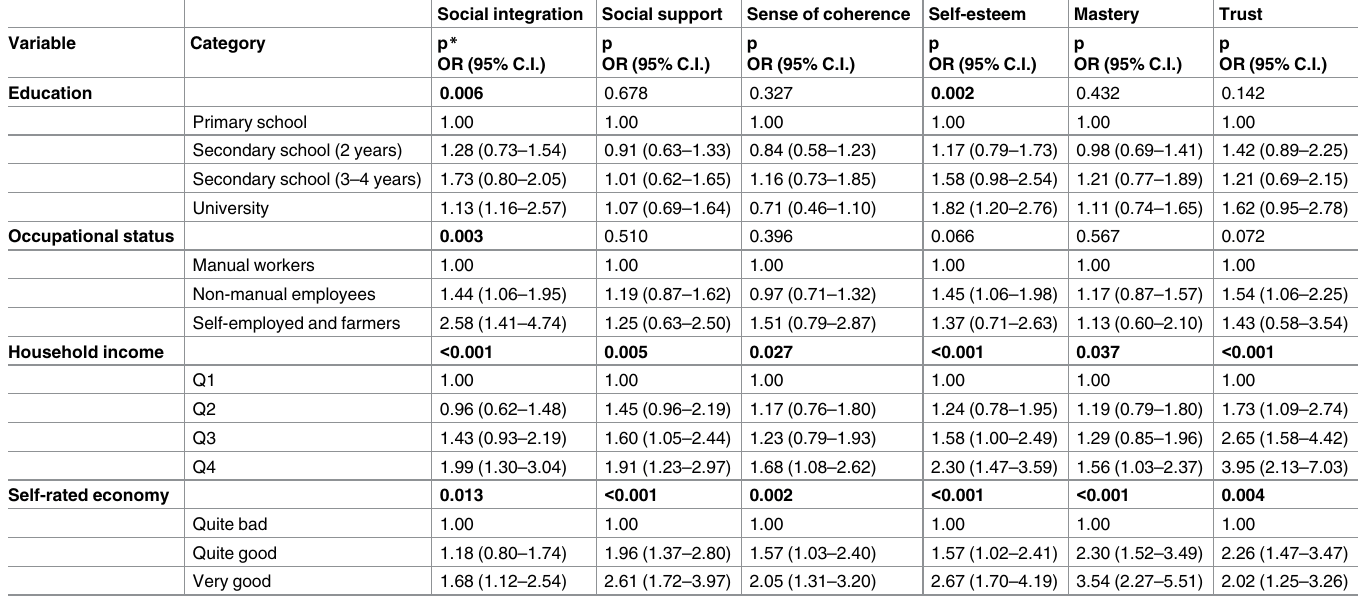
Table 5. Logistic regression models of socioeconomic status and psychosocial resources, adjusted for age, sex, country of birth and employment status. Social integration Social support Sense of coherence